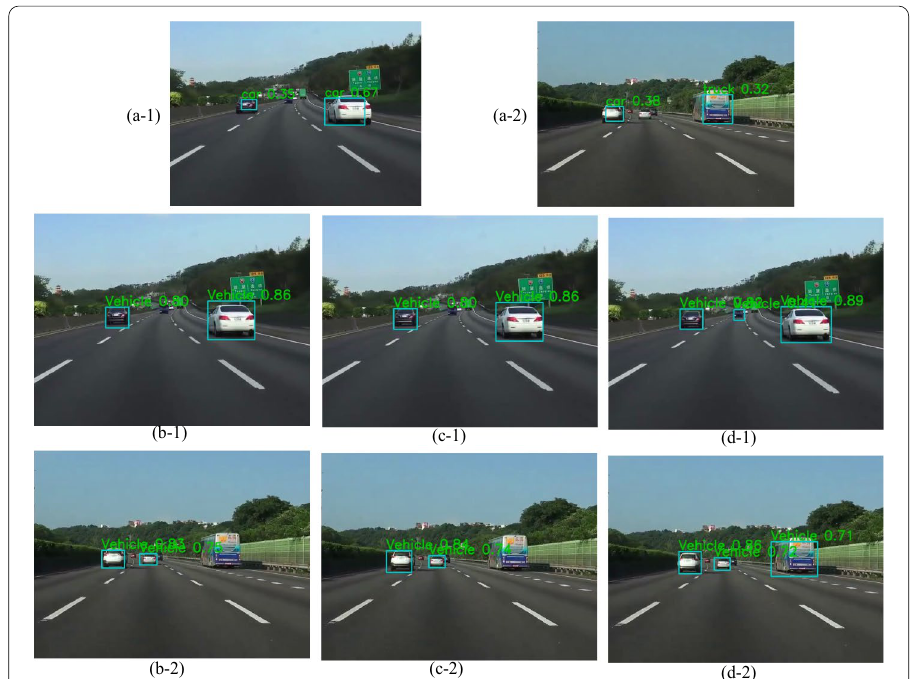
Fig. 10 Detection examples achieved by: a YOLOv2 with COCO; b YOLOv2_Re‑trained; c YOLOv2_Reduced and d the proposed